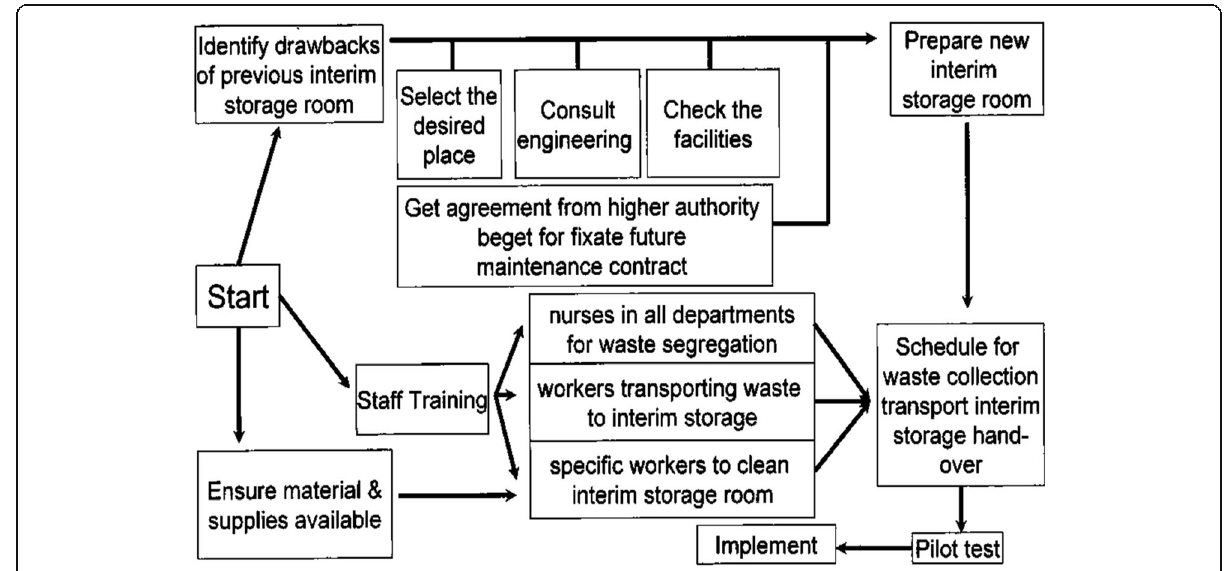
Fig. 3 The plan of the procedures of operating